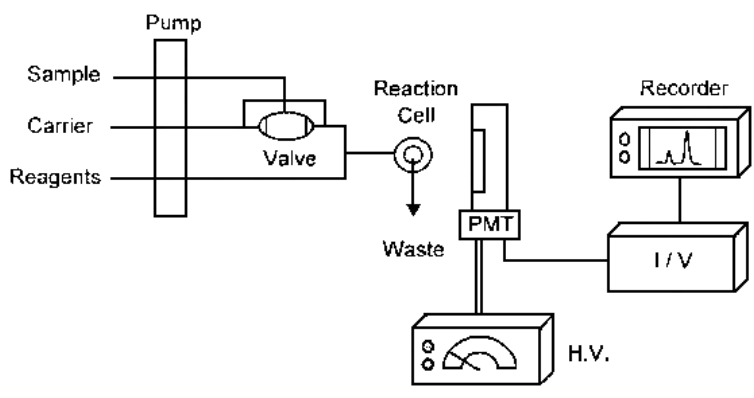
Figture 2. schematic illustration of a typical FI-CL analsis